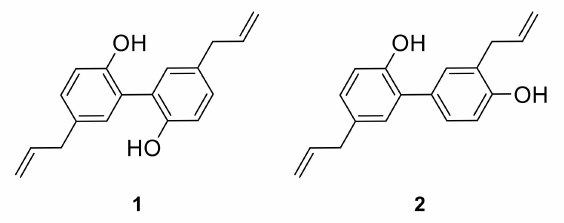
Figure 1. Chemical structures of magnolol (1) and honokiol